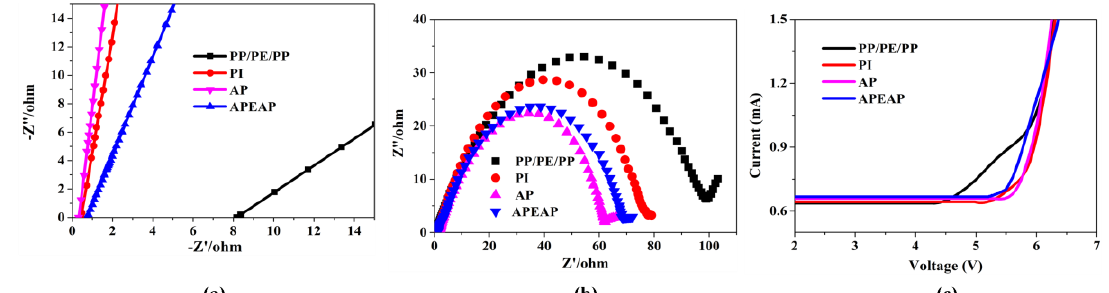
Figure 7. Electrochemical performance of different separators: ( a ) Impedance spectra of the PP/PE/PP, PI, AP, and APEAP separator; ( b ) The AC impedance spectra of the half-cell with different separators; ( c ) Linear sweep voltammograms of different separators.